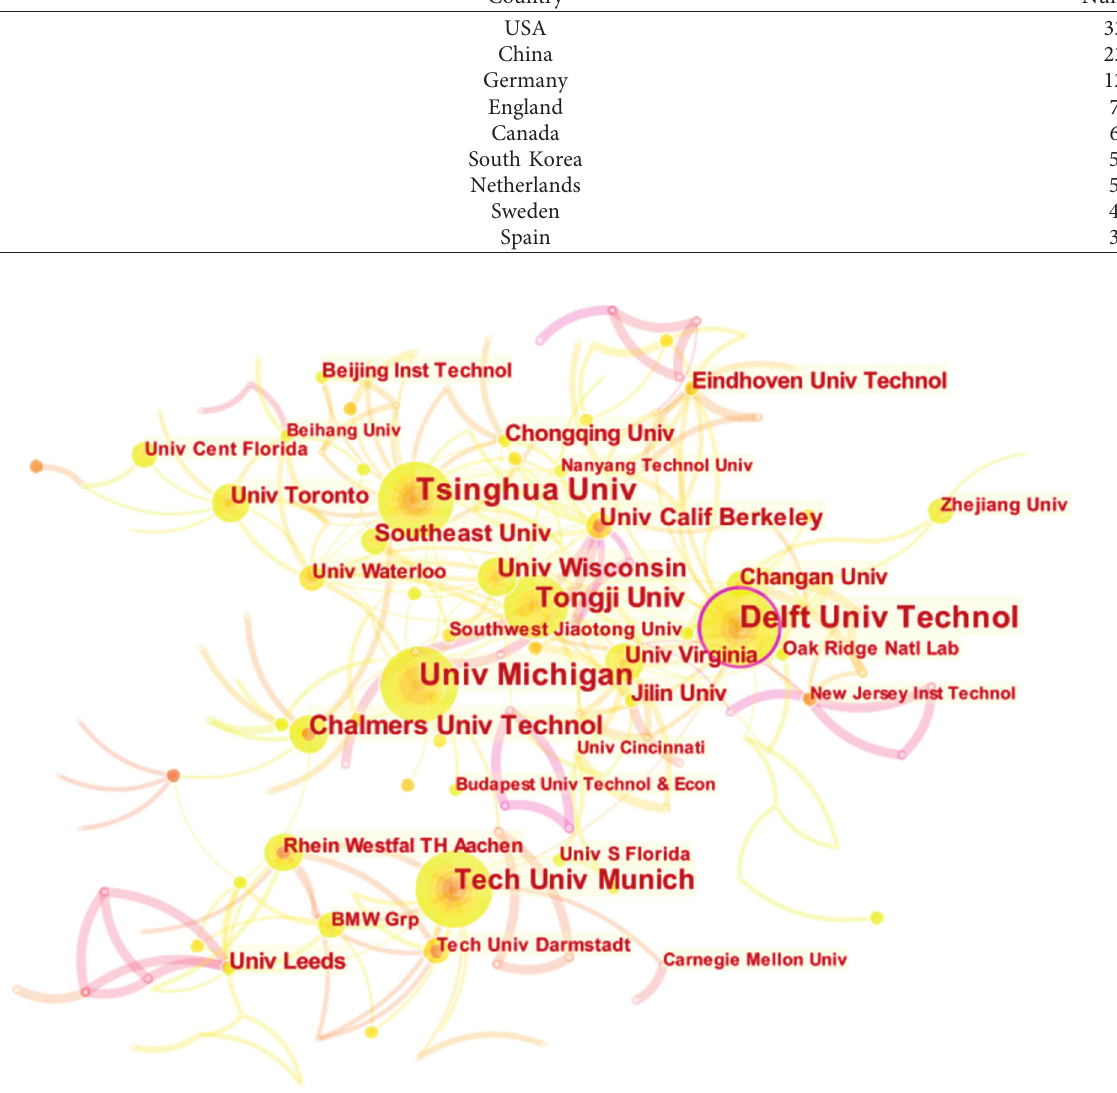
Figure 5: Organization collaboration network. Table 3: Number of articles published by